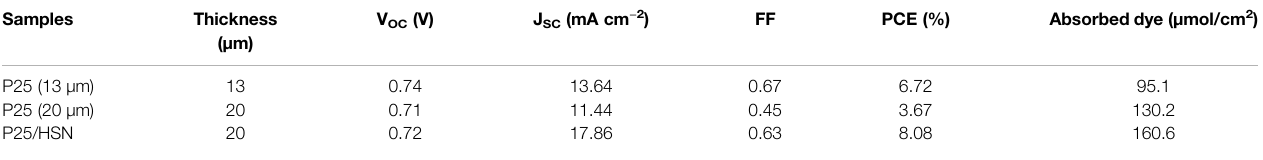
TABLE 2 | Comparison of relevant parameters for cells Based on Photoanodes of P25 (13 μ m), P25 (20 μ m) and P25/HSN.